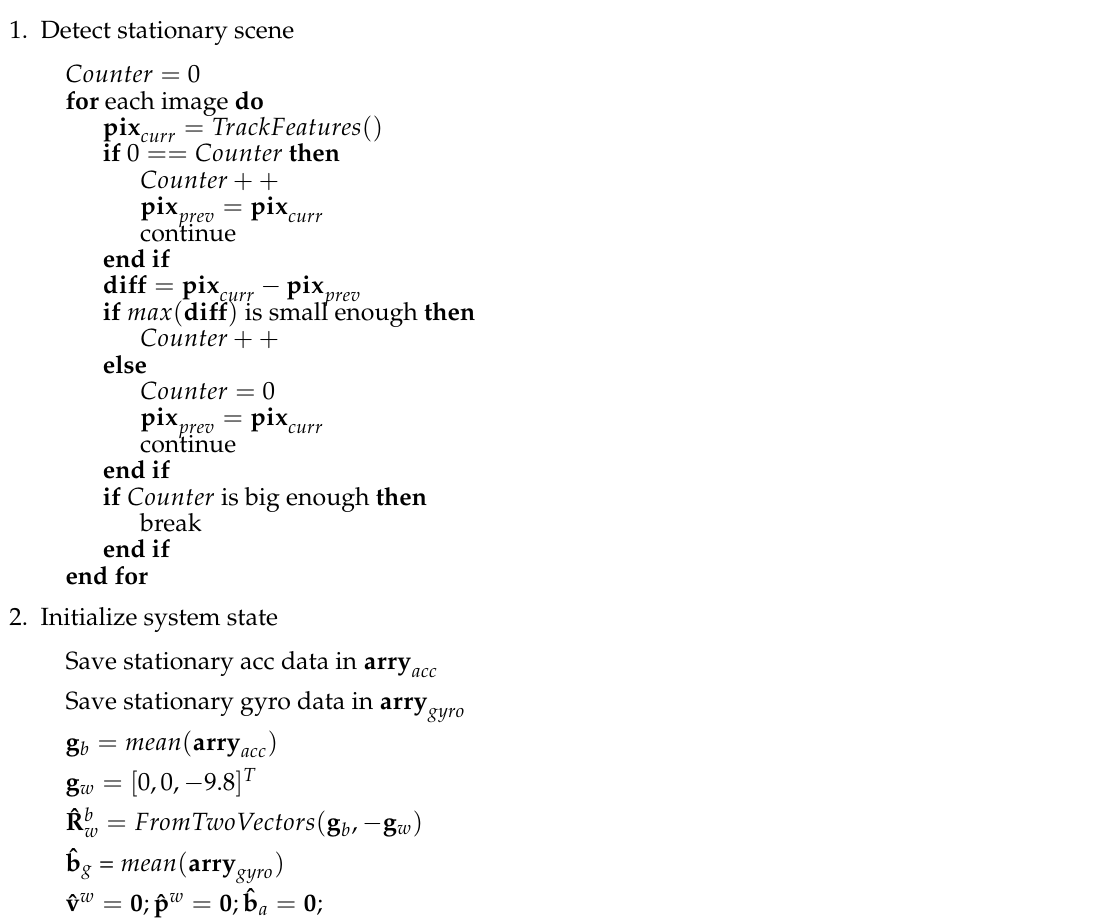
Algorithm 1 Automatic initialization